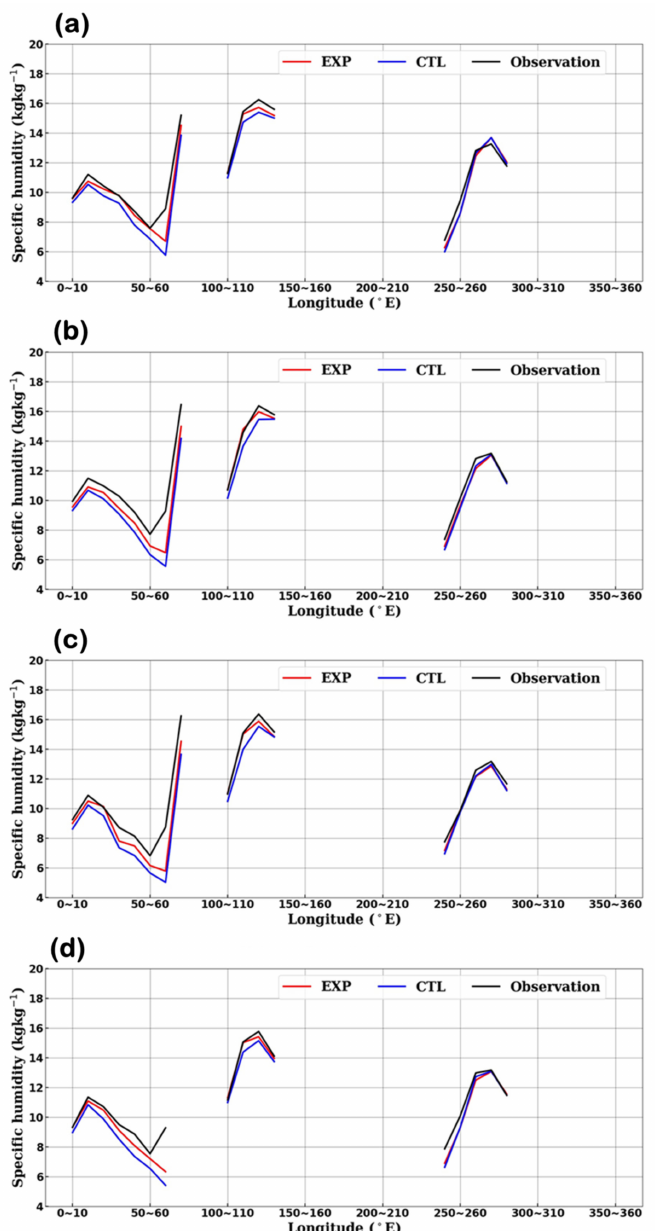
Figure 16. The variations of the near-surface-specific humidity according to the longitude and latitude from 30 ◦ N to latitude 50 ◦ N in the SYNOP observation and model forecasts (EXP and CTL) at 00 ( a ), 06 ( b ), 12 ( c ), and 18 ( d ) UTC. The 114-h forecasts for 06 and 18 UTC and 120-h forecasts for 00 and 12 UTC were